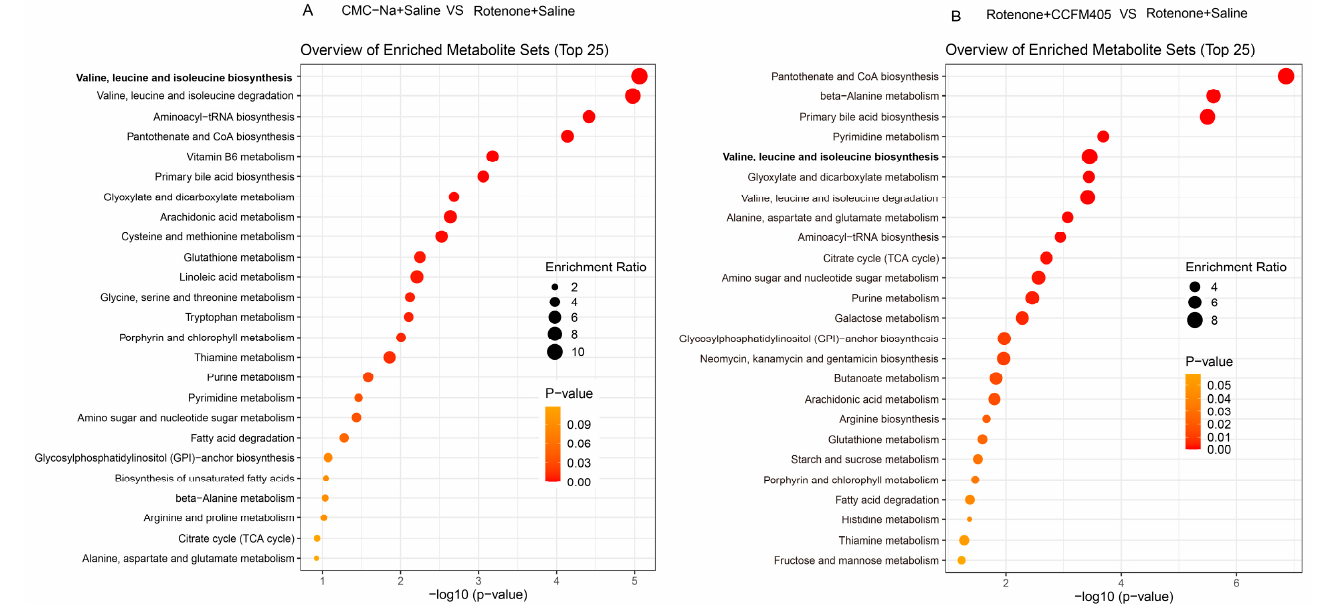
Figure 12. Metabolic pathway enrichment analysis of differential serum metabolites. ( A ) Normal control versus PD group; ( B ) L. plantarum CCFM405 group versus PD group. The color of the histogram represents the metabolic enrichment pathways with significant differences. The size of the dots in the left panel means the enrichment rate, n = 10/group.